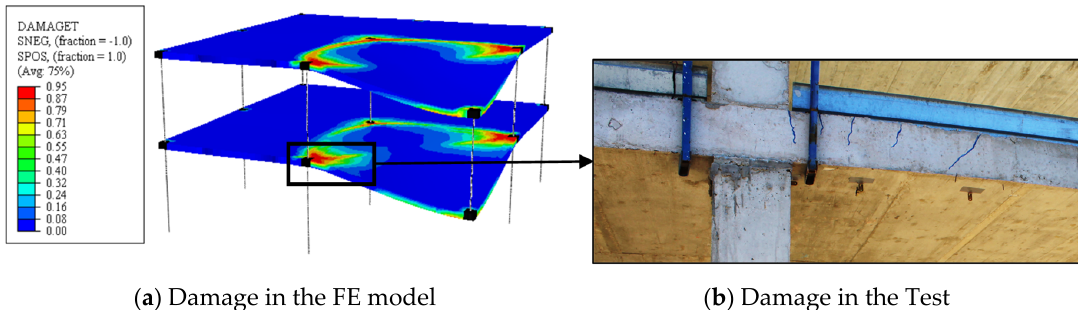
Figure 6. Comparison of the tensile damage (DAMAGET) between the FE model and test [28].